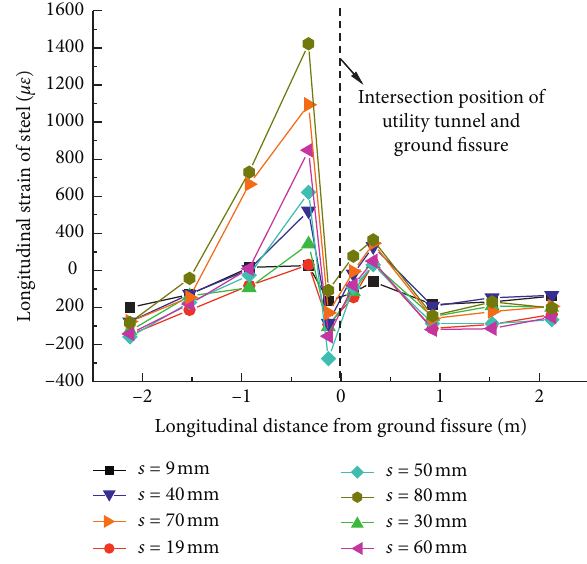
Figure 14: Longitudinal strain of bottom